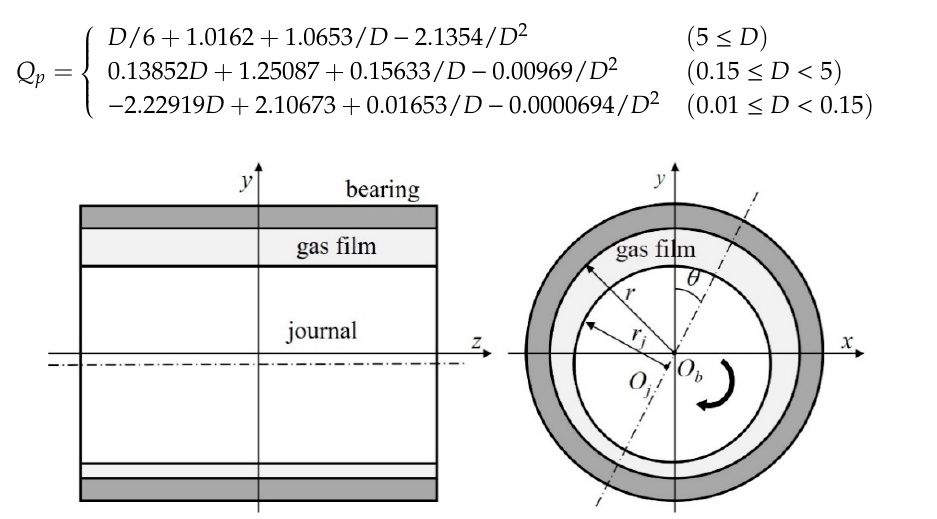
Figure 4. Schematic diagram of a typical bearing-rotor system.